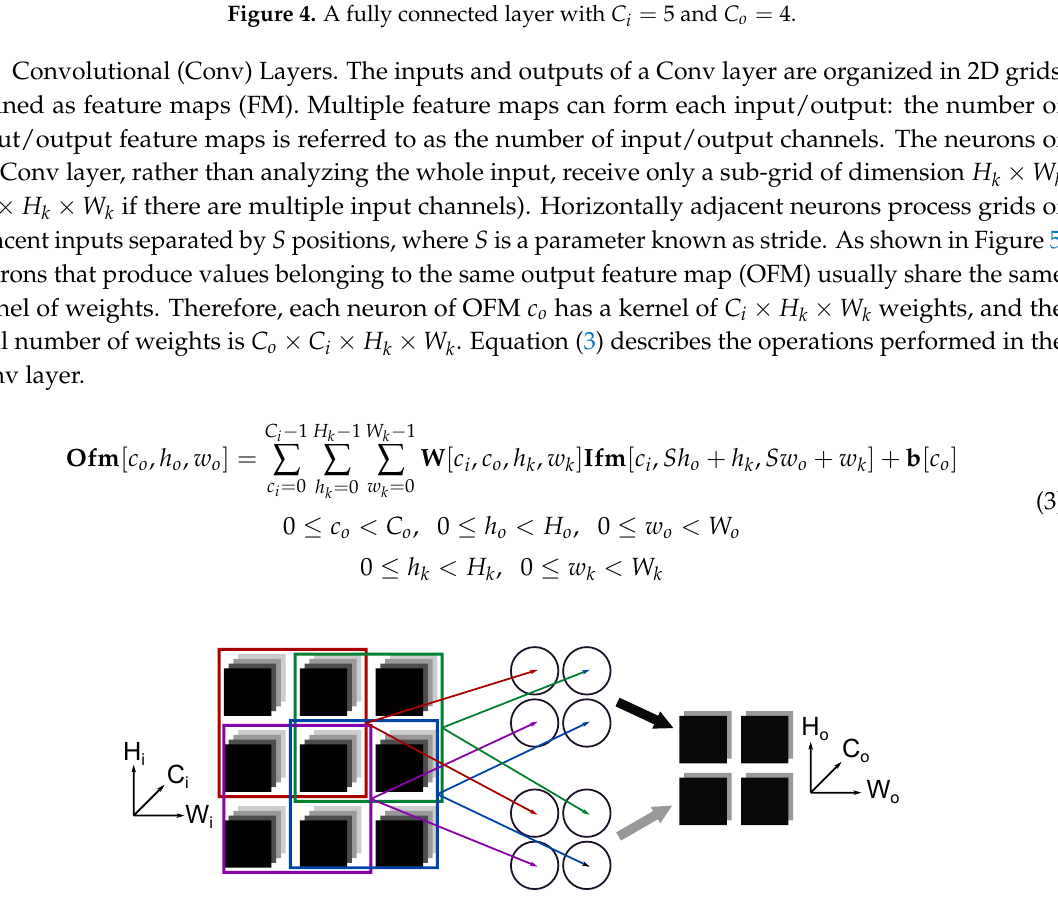
Figure 5. A convolutional layer with C i = 4, H i = W i = 3, C o = H o = W o = 2, H k = W k =